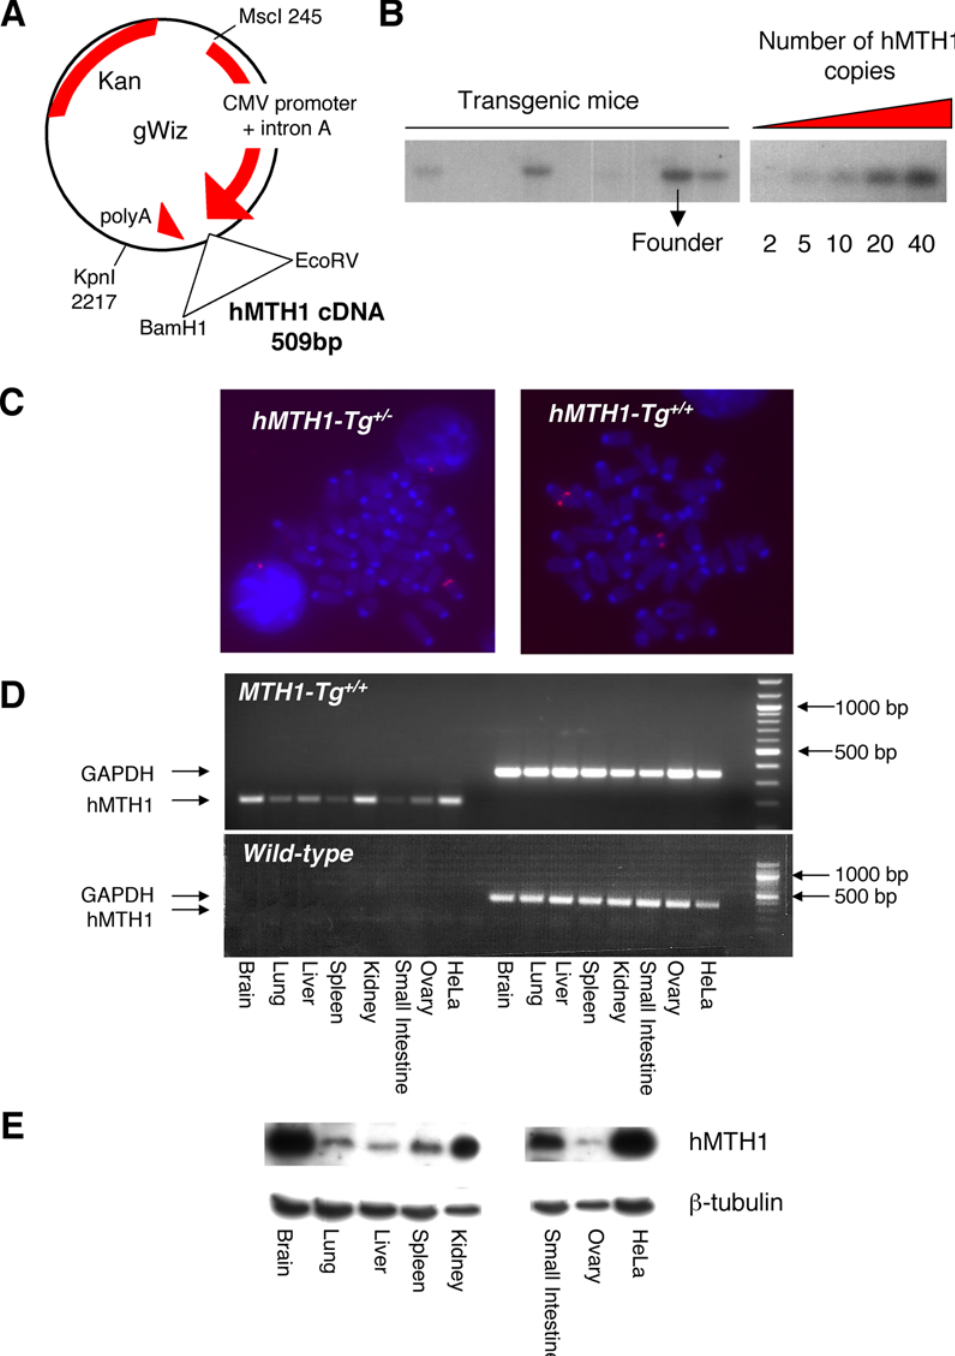
Figure 1. Construction and characterization of a transgenic mouse expressing the hMTH1 cDNA. (A) A BamH1-EcoRV fragment (509 bp) derived from pcDEB D [23] encoding the hMTH1 cDNA was subcloned into the gWIZ vector under the control of the CMV promoter. This vector transfected into wild-type MEFs expressed the hMTH1 protein (data not shown). The MscI-KpnI fragment (2481 bp) was used in the construction of the transgenic mouse. (B) Determination of transgene copy number. Genomic DNA from mouse tails was analysed by Southern blot analysis (left panel). In the right panel 2, 5, 10, 20, 40 copies of the MscI-KpnI fragment were analysed. Both blots were probed with the same probe. Copy number was determined by comparison. The arrow indicates the DNA from the mouse that was used as a founder for the colony. (C) Analysis by FISH of the number of hMTH1 integrations in hemizygous ( hMTH1-Tg + / 2 ) and homozygous ( hMTH1-Tg + / + ) strains. (D) Expression of hMTH1 mRNA. RT-PCR was performed using total RNA from the indicated organs and human specific primers. RT-PCR for the GADPH gene is used as an internal control. hMTH1 and GAPDH fragments are respectively 200 bp and 330 bp. (E) Western blot analysis of transgene expression. Total proteins (20–40 m g) from a range of tissues were separated by SDS polyacrylamide electrophoresis, blotted and probed with an antibody against hMTH1. b -tubulin was used as a loading control.